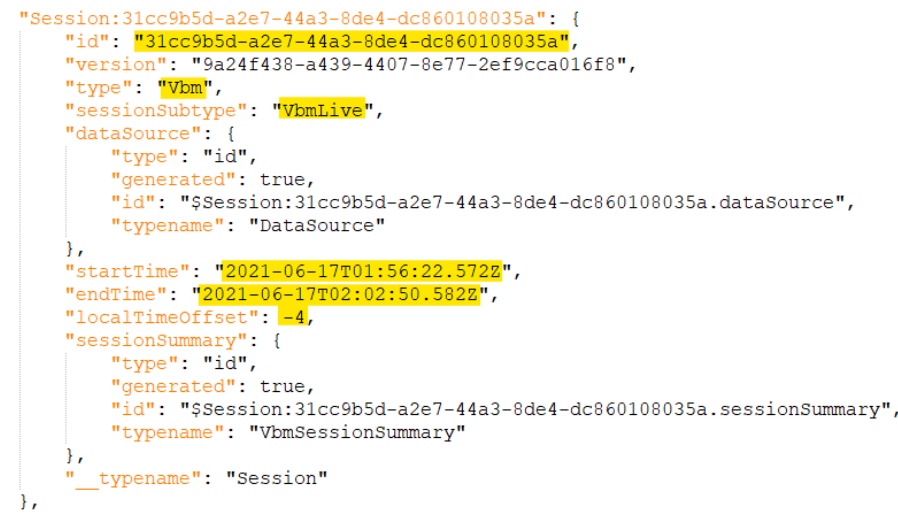
Figure 9. Session generated when the Amazon Halo device user used the Live Tone Analysis feature.